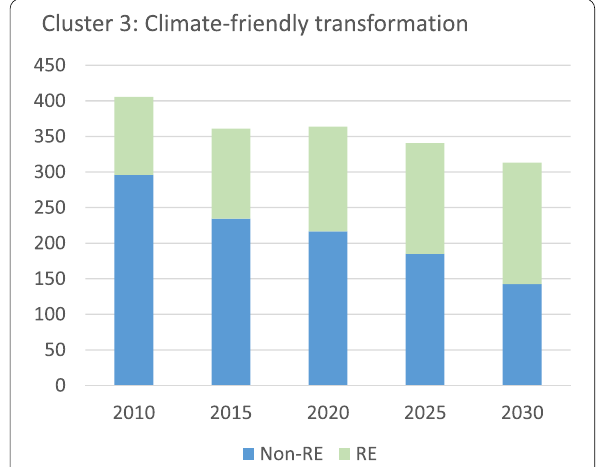
Fig. 6 Total consumption of energy between 2010 and 2030 in